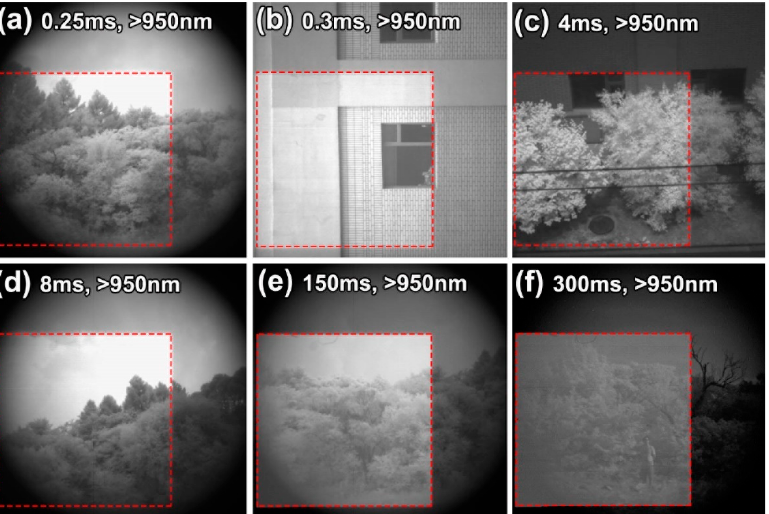
Figure 5. Comparison of near-infrared imaging performance between microstructured area and unprocessed area of CMOS image sensor at different integration times. The imaging conditions (shooting time, weather, location, light intensity, and integration time) corresponding to ( a – e ) are ( a ) 7 am, cloudy, outdoor, low light intensity, 0.25 ms; ( b ) 7 am, sunny, indoor, strong light intensity, 0.3 ms; ( c ) 7 am, sunny, outdoor, strong light intensity, 4 ms; ( d ) 7 pm, cloudy, outdoor, low light intensity, 8 ms; ( e ) 8 pm, cloudy, outdoor, weak light intensity, 150 ms; ( f ) 9 pm, cloudy, outdoor, weak light intensity, 300 ms,